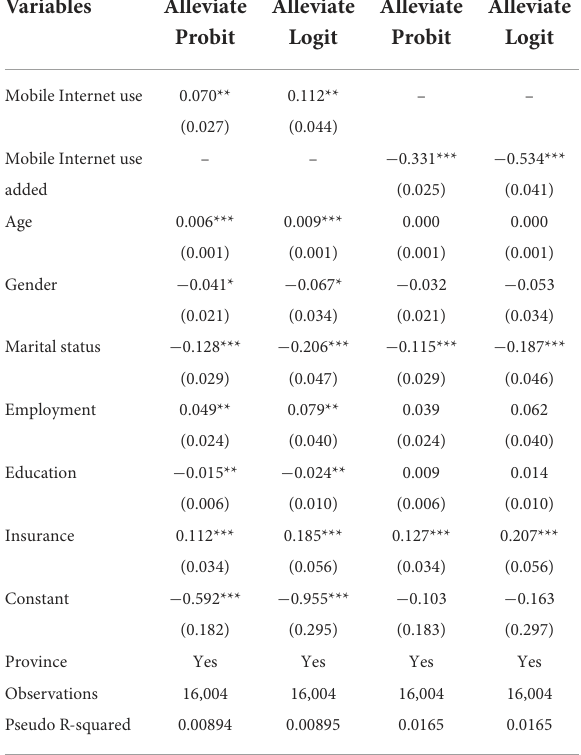
TABLE 9 Result of regressions based on the different purposes of mobile Internet use.